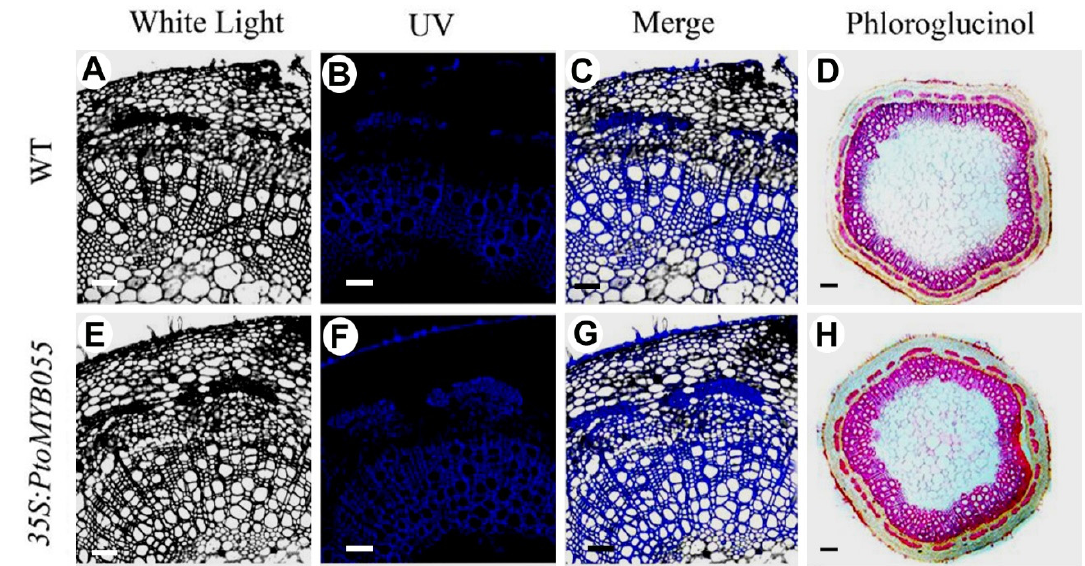
Figure 5. Ectopic deposition of lignin in PtoMYB055 -overexpressing poplar. ( A – C , E – G ) Laser scanning confocal microscopy of stem sections at the fifth internode in PtoMYB055 -overexpressing transgenic poplar. ( D , H ) Stem sections at the fifth internode were stained by phloroglucinol-HCl. Scale bars = 50 µ m ( A – C , E – G ), 500 µ m ( D , H ). Table 1. The lignin content in 35S-PtoMYB055-overexpressing poplar and the wild type. Lines Lignin (mg / 100 mg) Wild